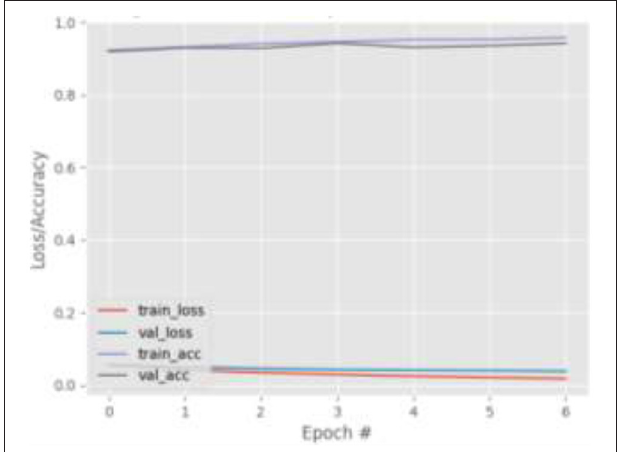
FIGURE 4 | Results for Face + FL on GazeCapture dataset.